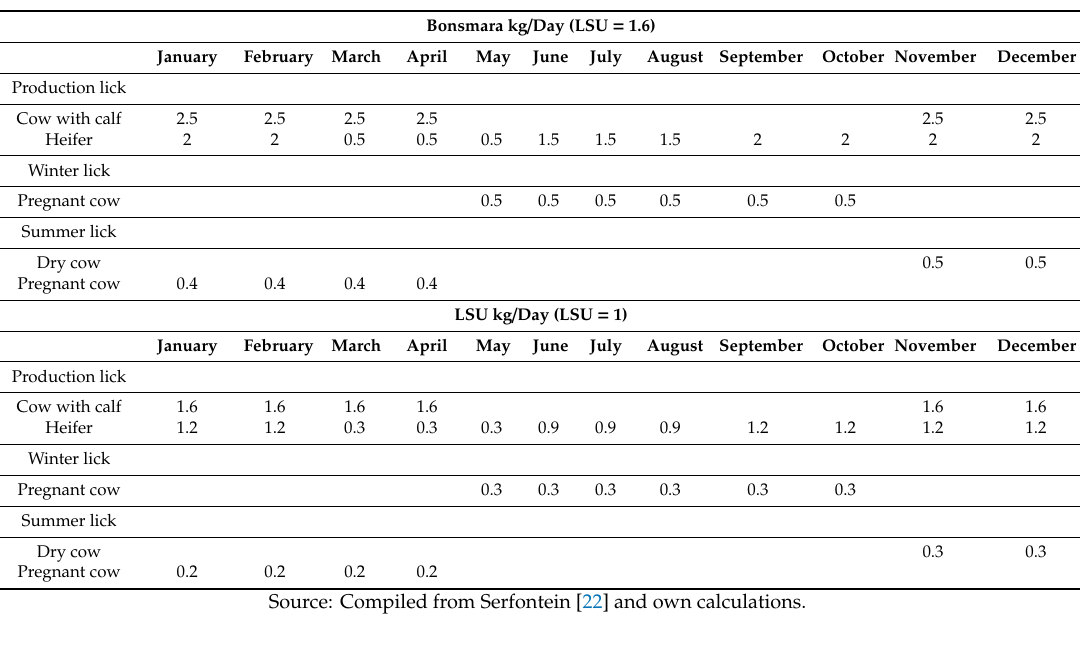
Table 4. Supplementary feed requirements of the Bonsmara and a LSU (kg / day).